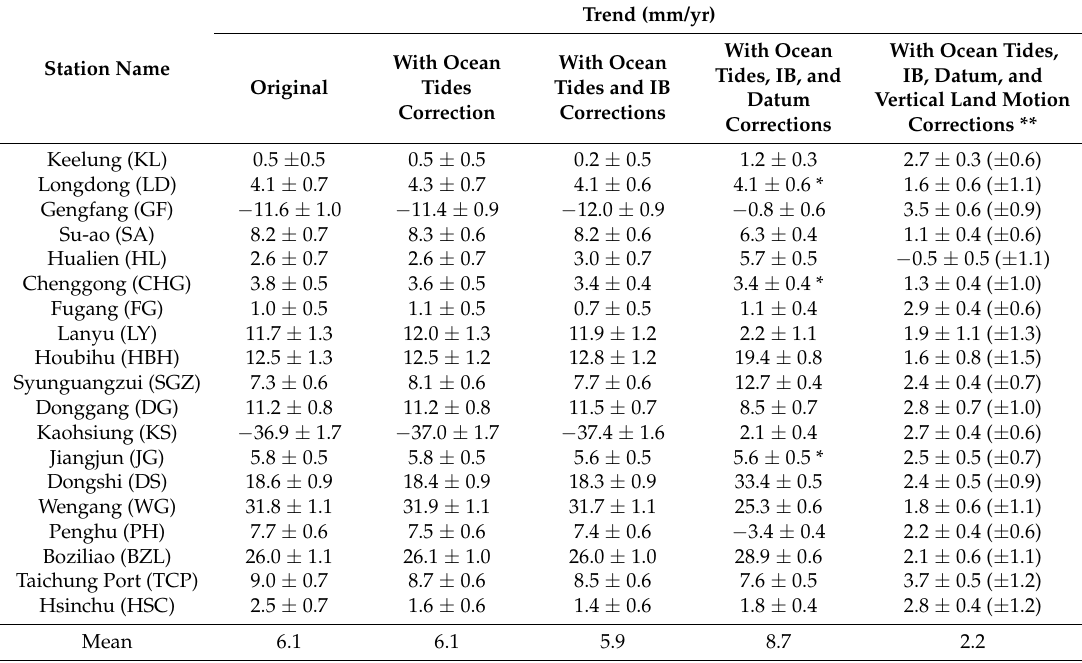
Sea-level trends derived from tide gauges with different geophysical and datum corrections